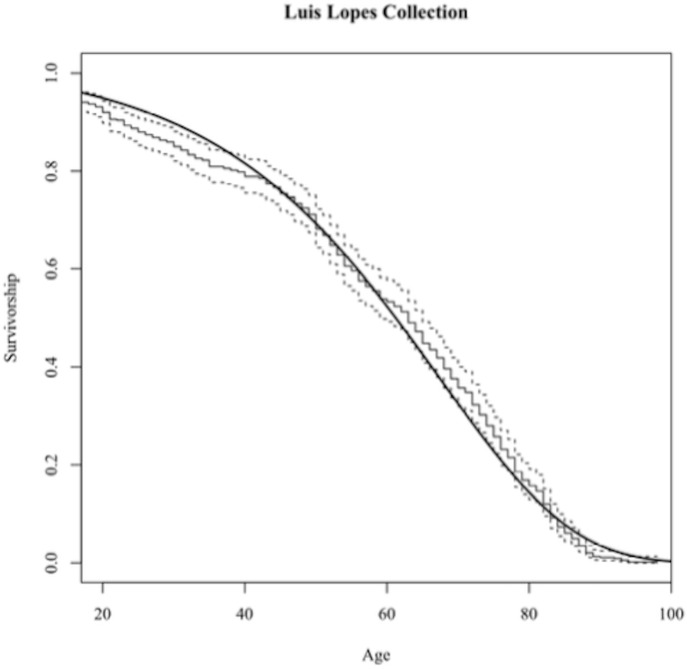
A Gompertz function (solid line) fit to a Kaplan-Meier survivorship (stepped lines) curve in historic Portuguese.